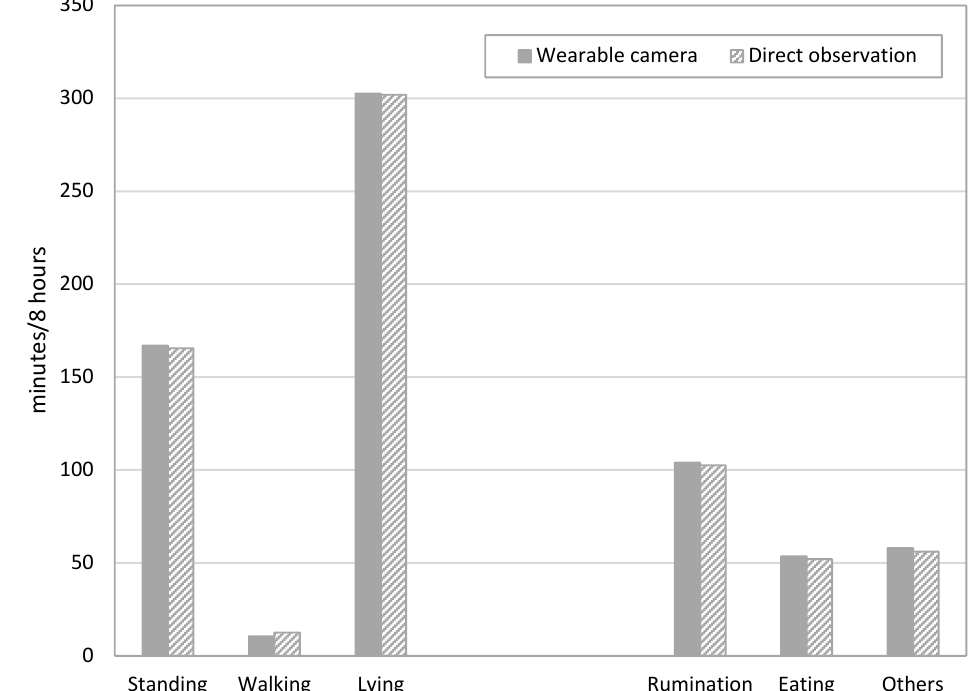
Table 4. Differences between wearable camera observation and direct observation per posture for each calf.